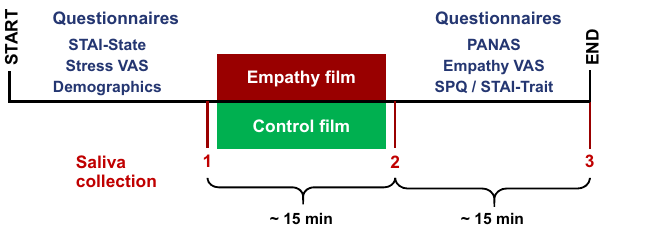
Figure 1. Schematic presentation of data collection sessions. STAI State-Trait Anxiety Inventory, VAS visual analogue scale, PANAS Positive and Negative Affect Schedule, SPQ Saarbrucken Personality Questionnaire.